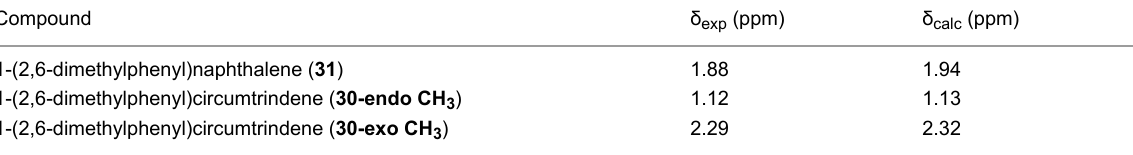
Table 1: Calculated (B3LYP/6-31G**) and experimentally obtained NMR chemical shifts of methyl groups in compounds 30 and 31 .